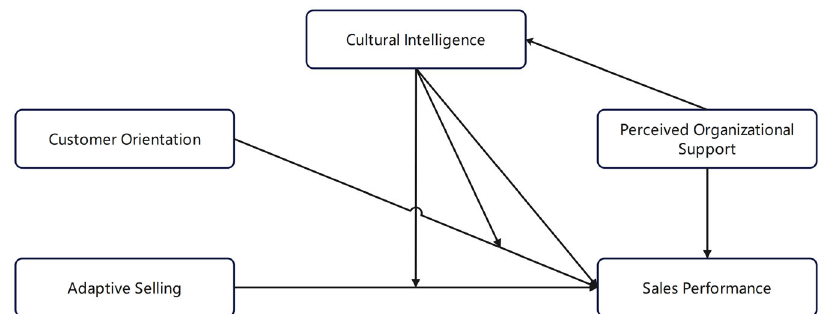
Fig. 1 Conceptual research